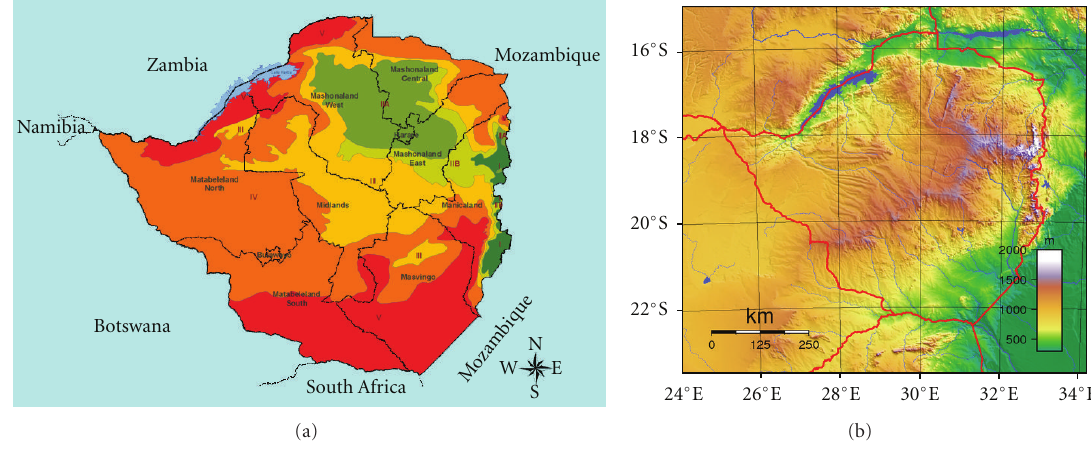
Figure 1: (a) boundaries of agroecological regions I to V of Zimbabwe and (b) the complex nature of relief. Elevated regions cutting diagonally across the country are the Great Dyke Mountains and over the eastern boarder are the Eastern Highlands.